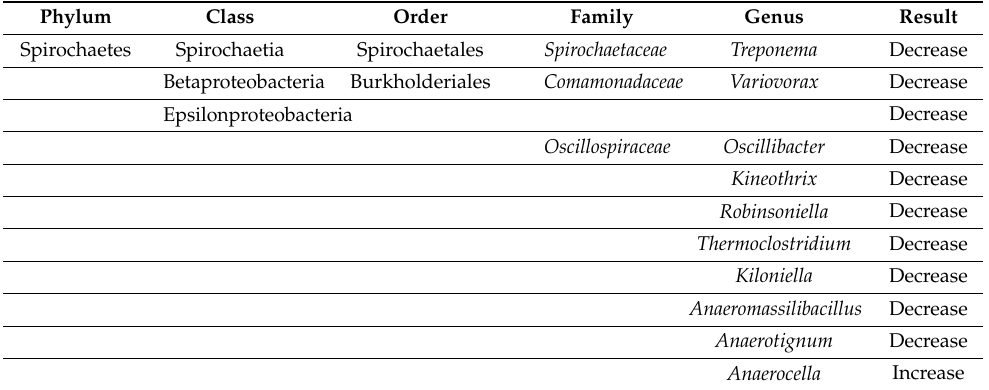
Table A6. Taxa table showing the relationships between identified OTUs via MetagenomeSeq. The observed change in OTU abundance in B + voles compared with B - voles is summarised in the ‘Result’